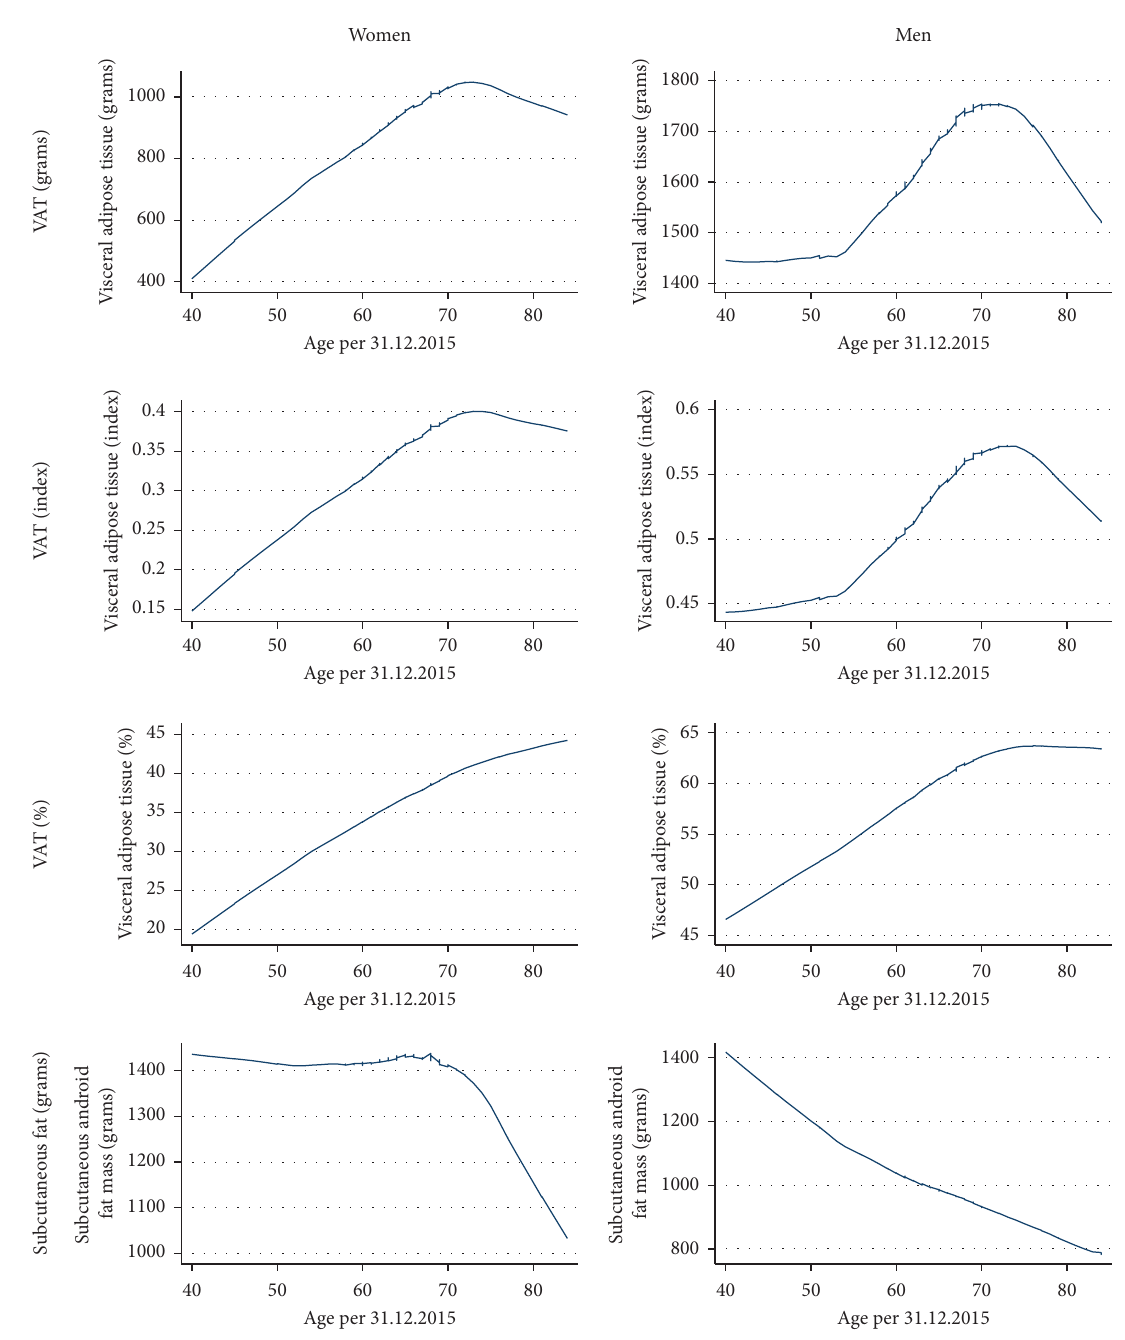
Figure 3: VAT (g, index, and %) and subcutaneous fat (g) in android region over age: the Tromsø Study